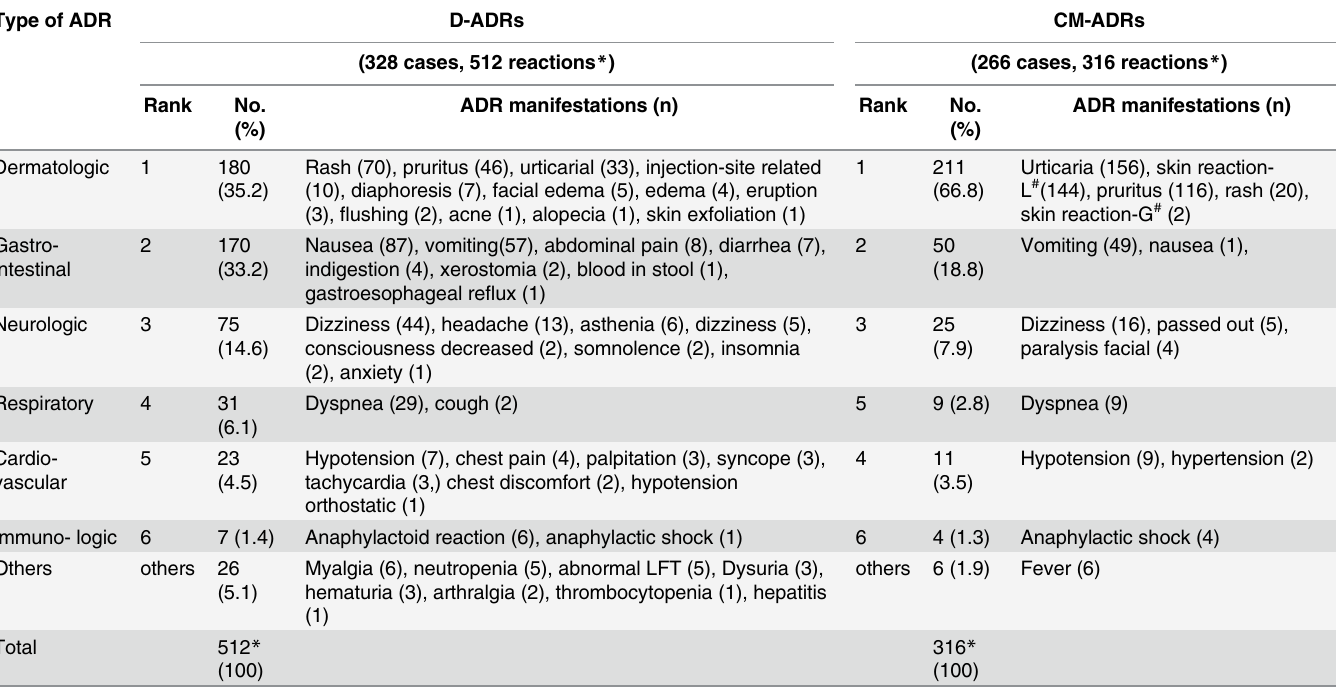
Table 4. Classification of adverse drug reactions (ADRs) according to the affected organ or system.